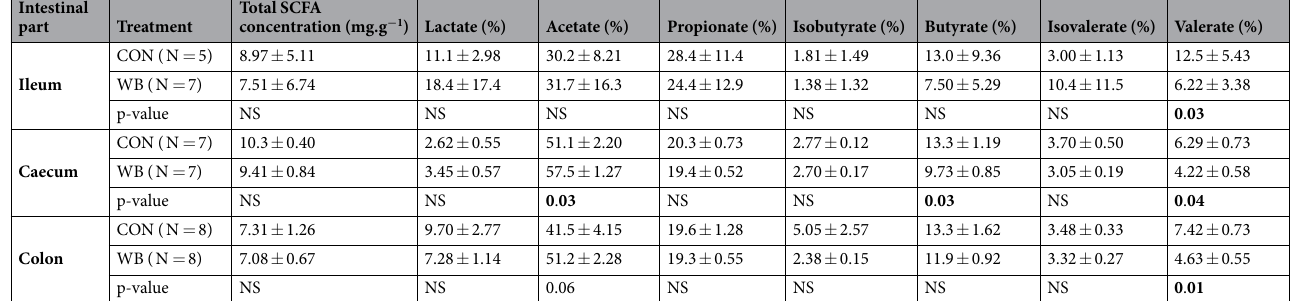
Table 4. SCFA concentrations and molar ratios of piglets’ digesta in the terminal ileum, caecum and colon. The sum is expressed in mg.g − 1 while other compounds are expressed as molar ratios ± SEM.